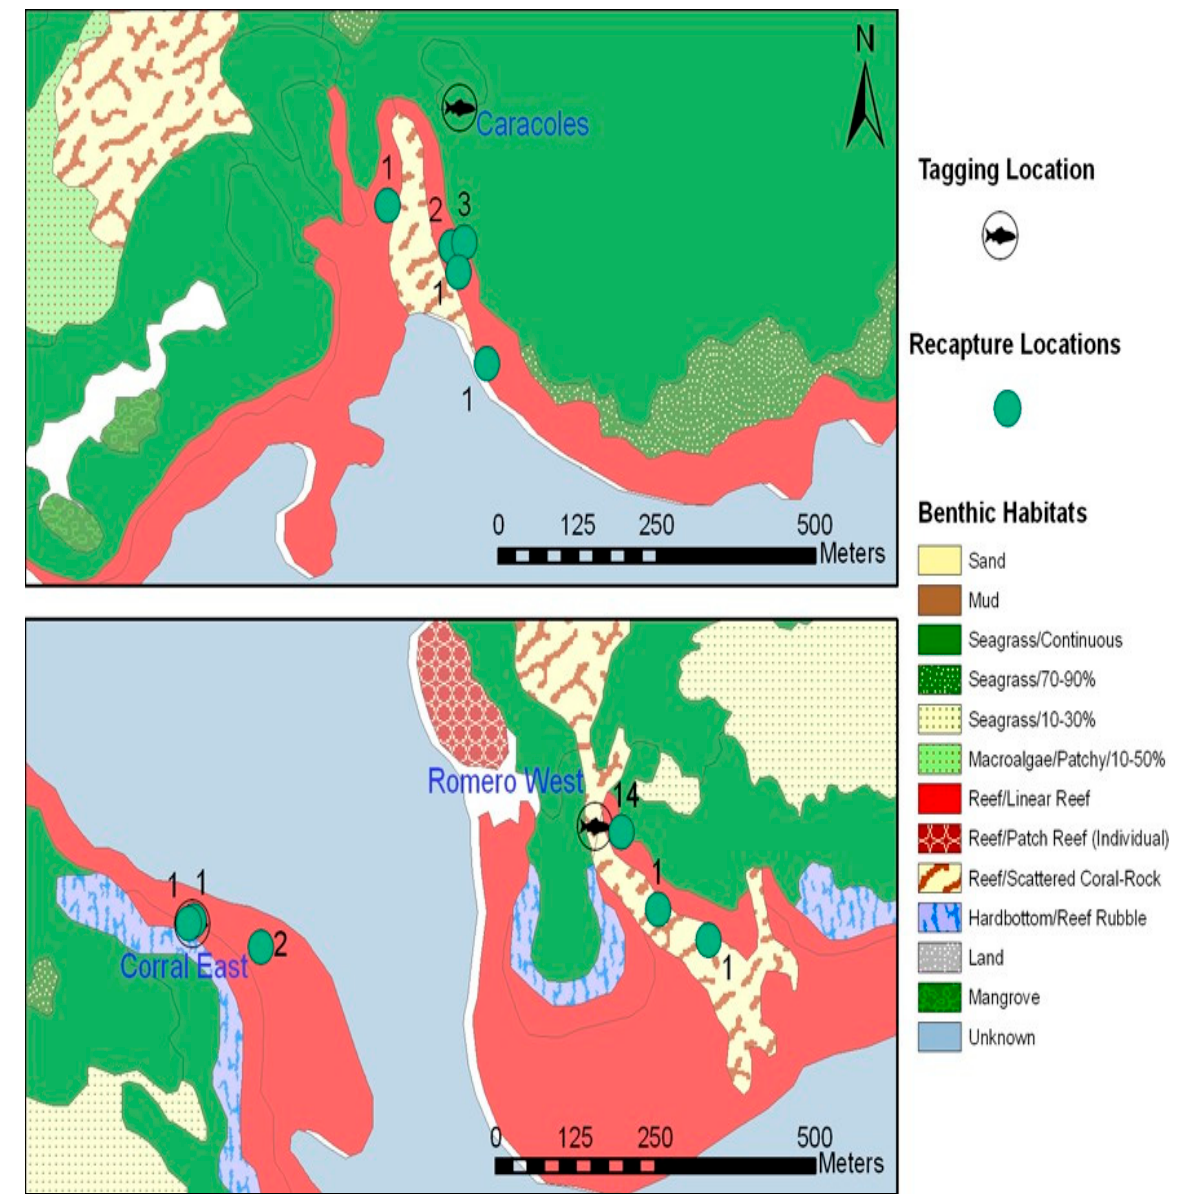
Figure 4. Tagging locations on three reefs with the benthic habitats (from Kendall et al. [37]) for La Parguera, Puerto Rico and the subsequent recovery locations and numbers for large juveniles.